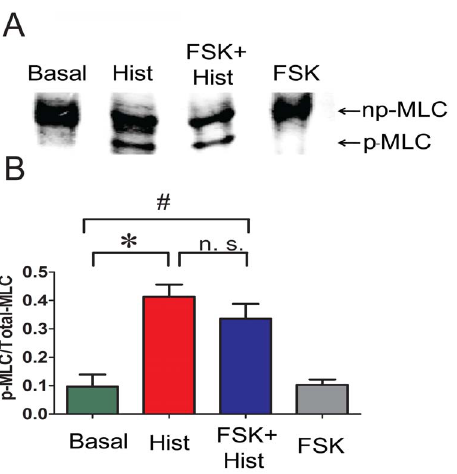
Figure 4. Preincubation with forskolin prevent histamine- induced increases in F-actin. PCA rings were treated the same way as described in Figure 3. Panel A: Treated tissues were homogonized and F- and G-actin were separated by centrifugation, F- actin was converted to G-actin, and measured by western blot, and quantitated compared to the standard actin loaded on the same gel. Panel B: F-actin concentration was calculated and cumulative data is plotted n=7, p , 0.05. *significance between Histamine and all other groups.